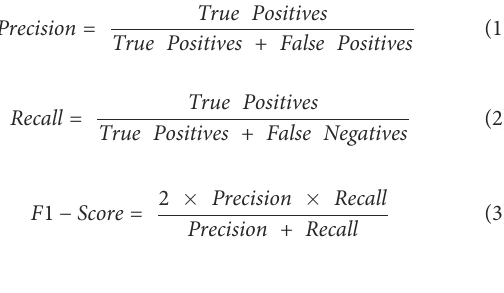
TABLE 3 Hyperparameters used to fi ne-tune the model.